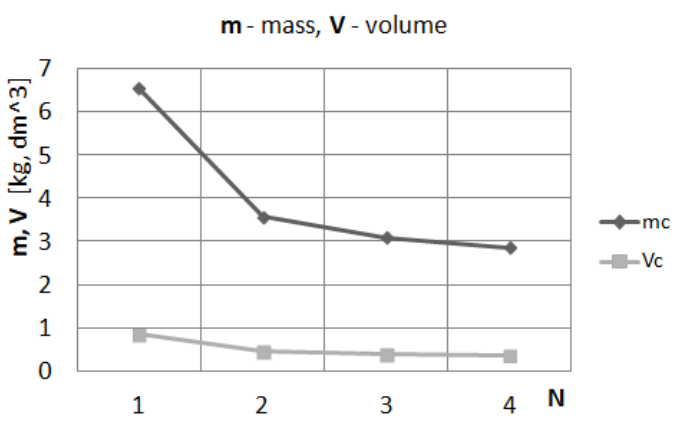
Figure 14. Total lengths L and external radius r e vs. number of discs N.